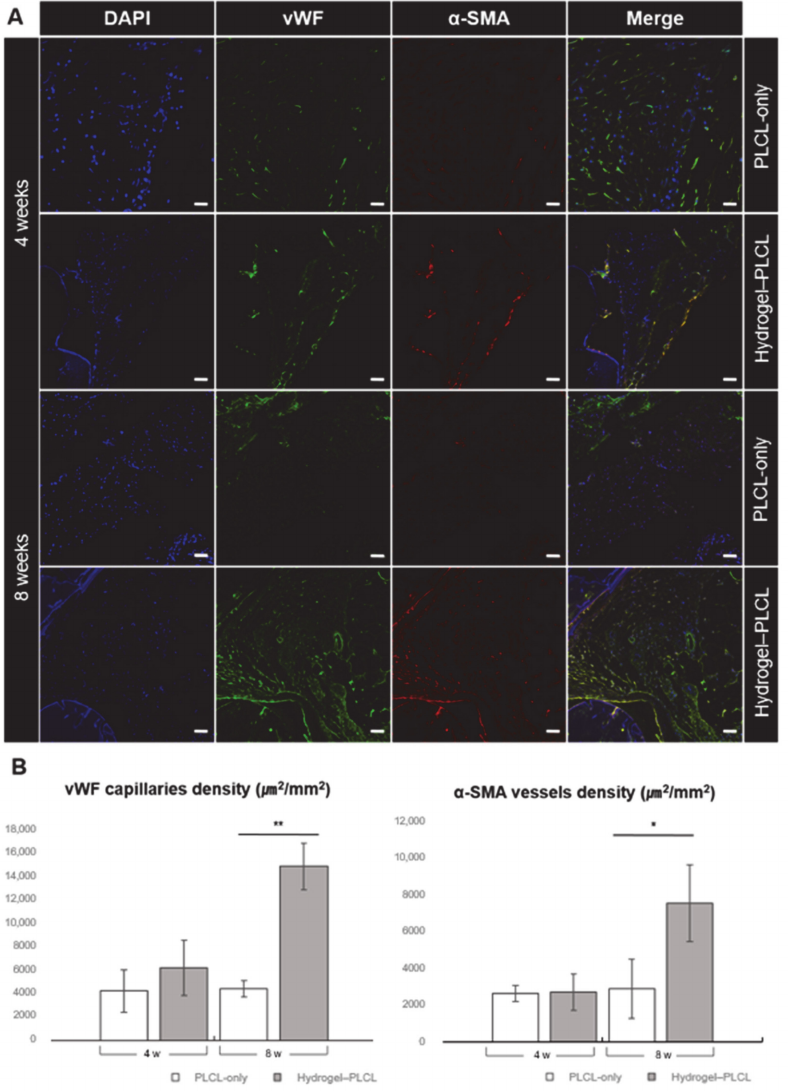
Figure 11. Analysis of vessel formation in the specimens after 4 and 8 weeks in vivo. ( A ) Immunoflu- orescence image of the PLCL-only group and hydrogel–PLCL complex construct 4 and 8 weeks after subcutaneous implantation. ( B ) von Willebrand factor (vWF) and α -smooth muscle actin ( α -SMA) density of the specimens 4 and 8 weeks after subcutaneous implantation (stained area µ m 2 /total